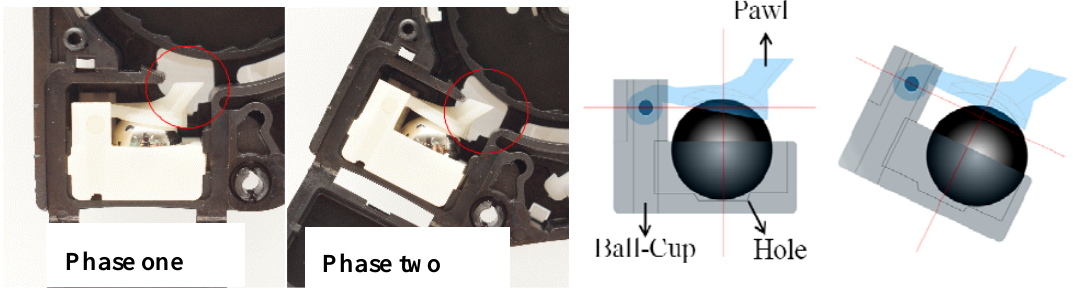
Figure 3. CG type emergency lock schematic motion.